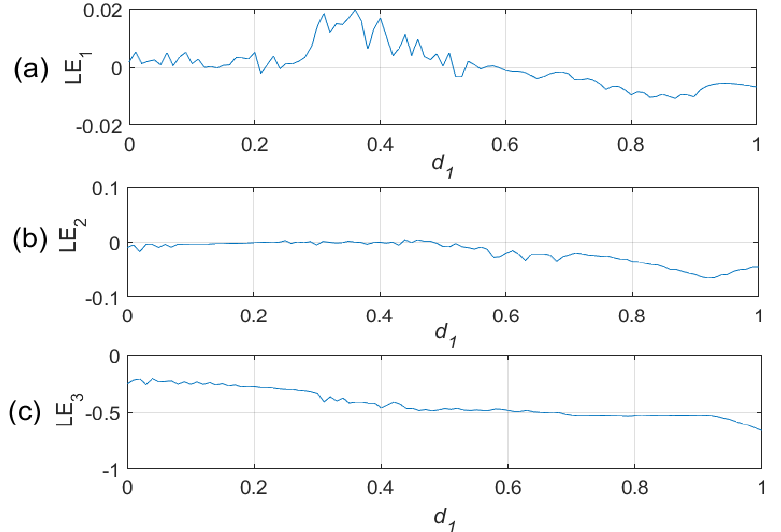
Figure 4. The Lyapunov exponents with the varying parameter d